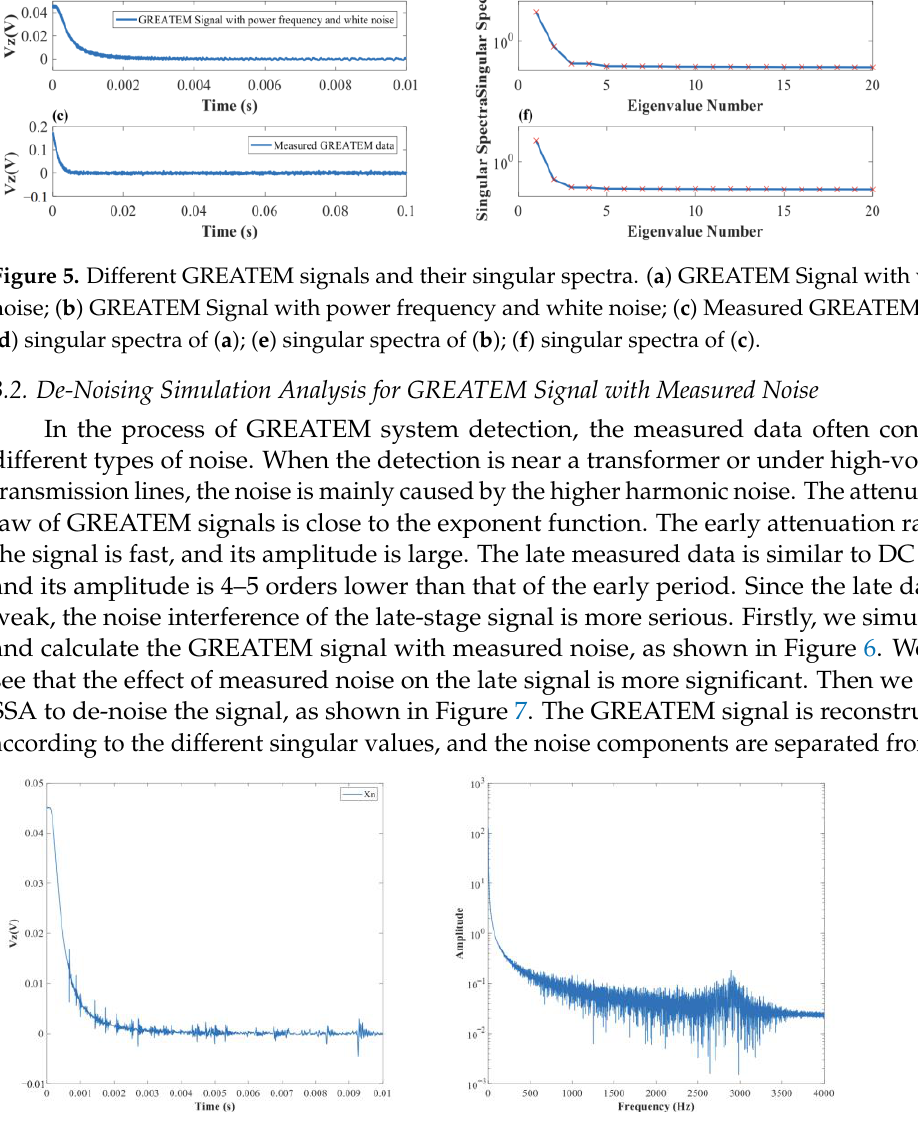
Figure 7. The separated signals after SSA. ( a ) GREATEM signal; ( b ) frequency spectrum of GREATEM signal; ( c ) noise; ( d ) frequency spectrum of noise. Figure 7a is the reconstructed GREATEM signal, and Figure 7b is the separated measured noise. Figure 8 shows the signal comparison before and after SSA de-noising. The Xn is the calculated GREATEM signal with noise, the SSA is the reconstructed GREATEM signal by SSA, and Sn is the calculated GREATEM signal without noise. Af- ter comparison with Figure 6, the reconstructed signal fits well with the calculated GREATEM signal. This verifies that the SSA algorithm could effectively separate the GREATEM simulation signal.